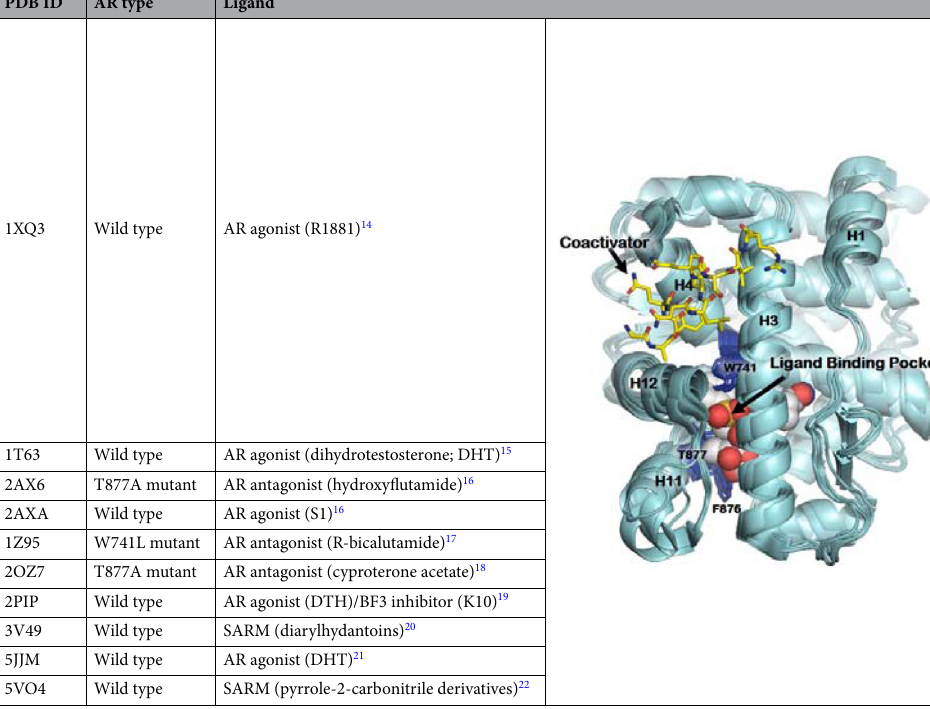
Table 1. X–ray crystal structures of AR LBD from Protein Data Bank and their 3D structural alignment complexed with various ligands. The key mutant residues (W741, T877 and F876) near the binding site for the ligands are represented as colored in blue. Image was created by using Visual Molecular Dynamics (VMD) v1.9.3 52